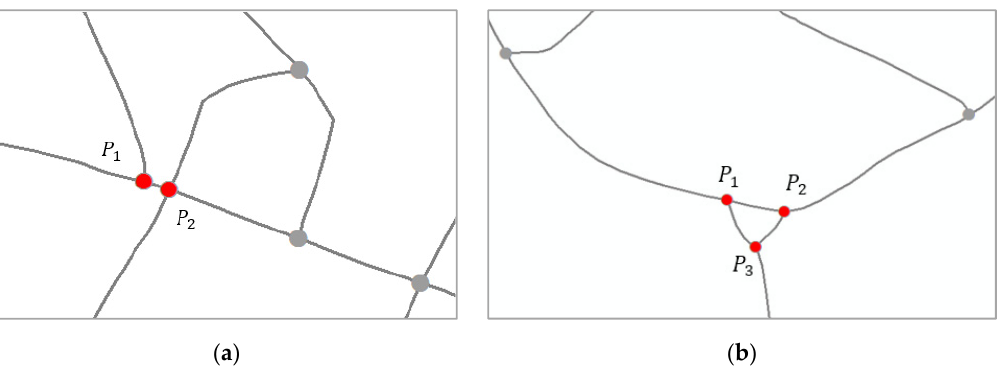
Figure 5. Examples of very close adjacent junction nodes: ( a ). two junction nodes, ( b ) three junction nodes.